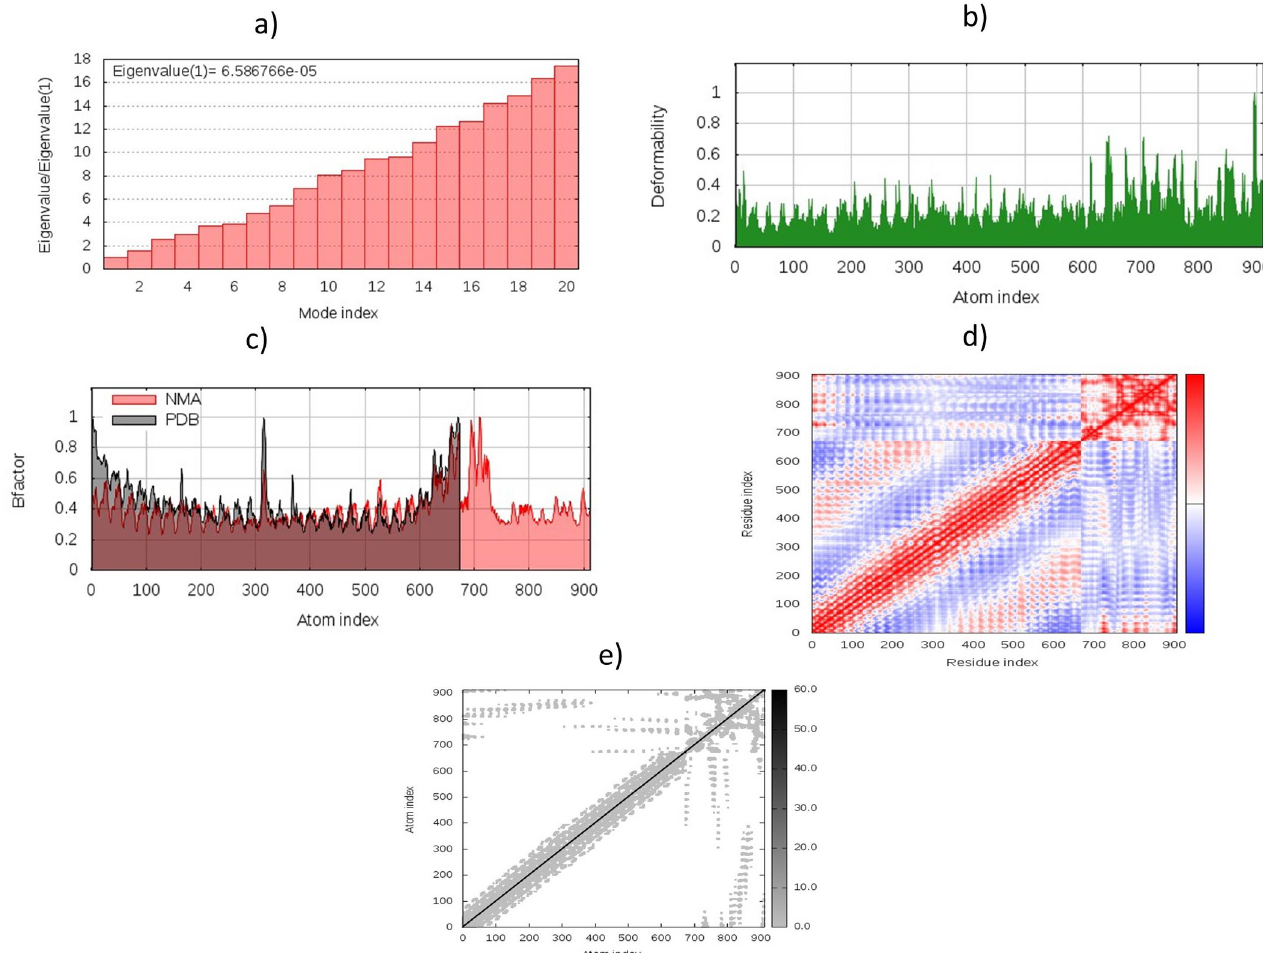
Fig 6. Molecular dynamics simulation of the MEP-TLR3 complex, showing (a) eigenvalue; (b) deformability; (c) B-factor; (d) covariance matrix; and (e) elastic network analysis.